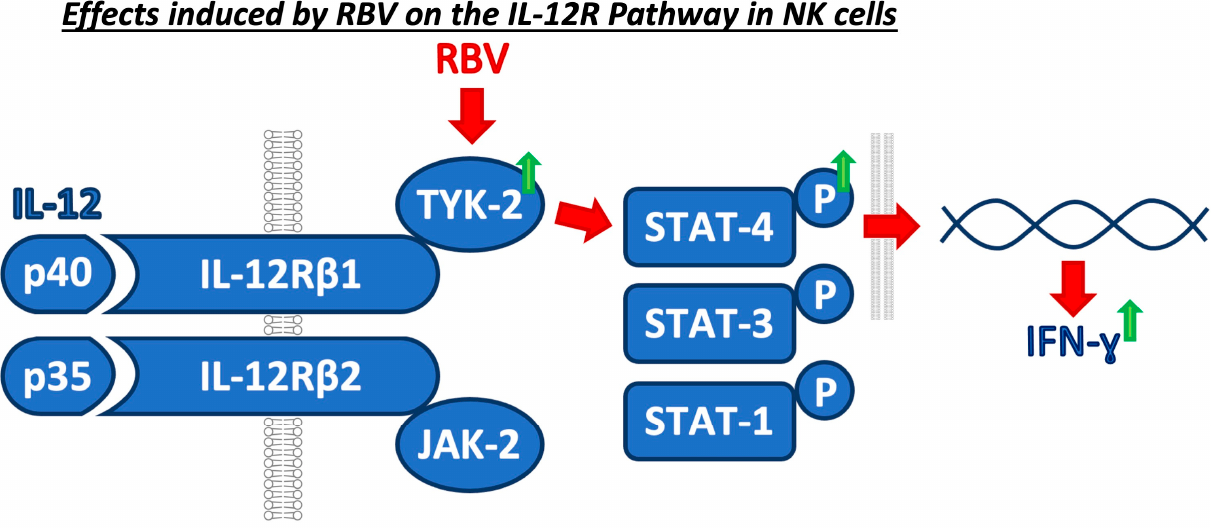
Figure 6. Concluding graphical summary of the identified mechanism of RBV on the IL-12 path-